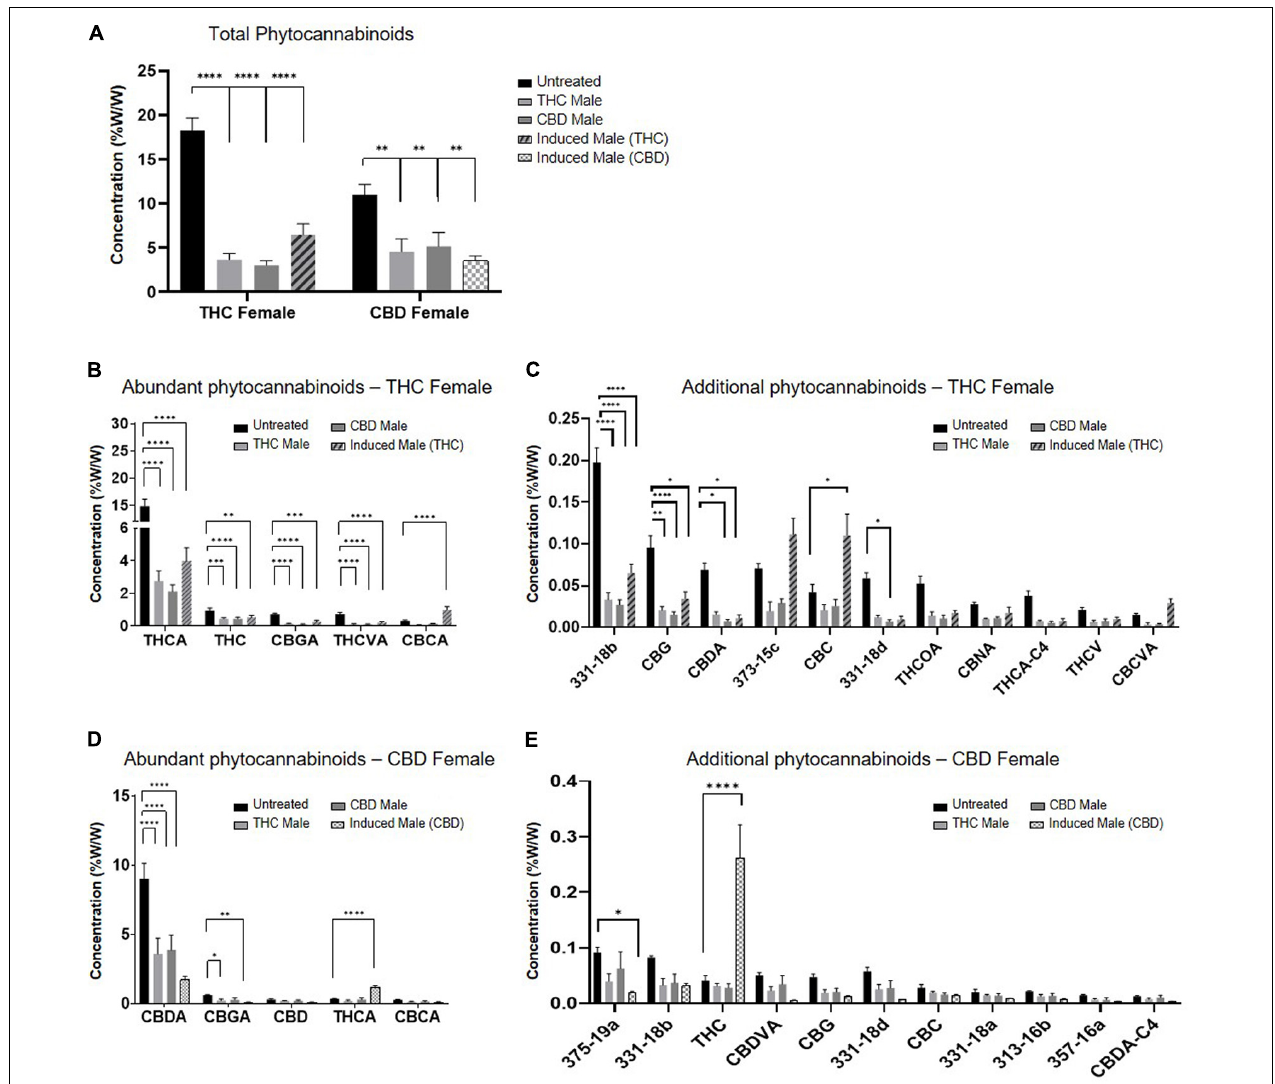
FIGURE 2 | Phytocannabinoids quantity predominantly decreases after fertilization with all types of males. (A) Total phytocannabinoid concentrations and (B–E) Individual phytocannabinoid concentrations after fertilization relative to unfertilized control. Abundant phytocannabinoid concentrations were considered > 0.2% (B,D) and additional phytocannabinoid concentrations were 0.001–0.2% (C,E) in the unfertilized plants. Data are presented as mean ± SEM ( n = 4–6, %w/w) and statistically analyzed by two-way ANOVA followed by Dunnett’s multiple comparison test (* p ≤ 0.05; ** p ≤ 0.01; *** p ≤ 0.001; **** p ≤ 0.0001). Significance in C, E was calculated after excluding THCA and CBDA, respectively, from the